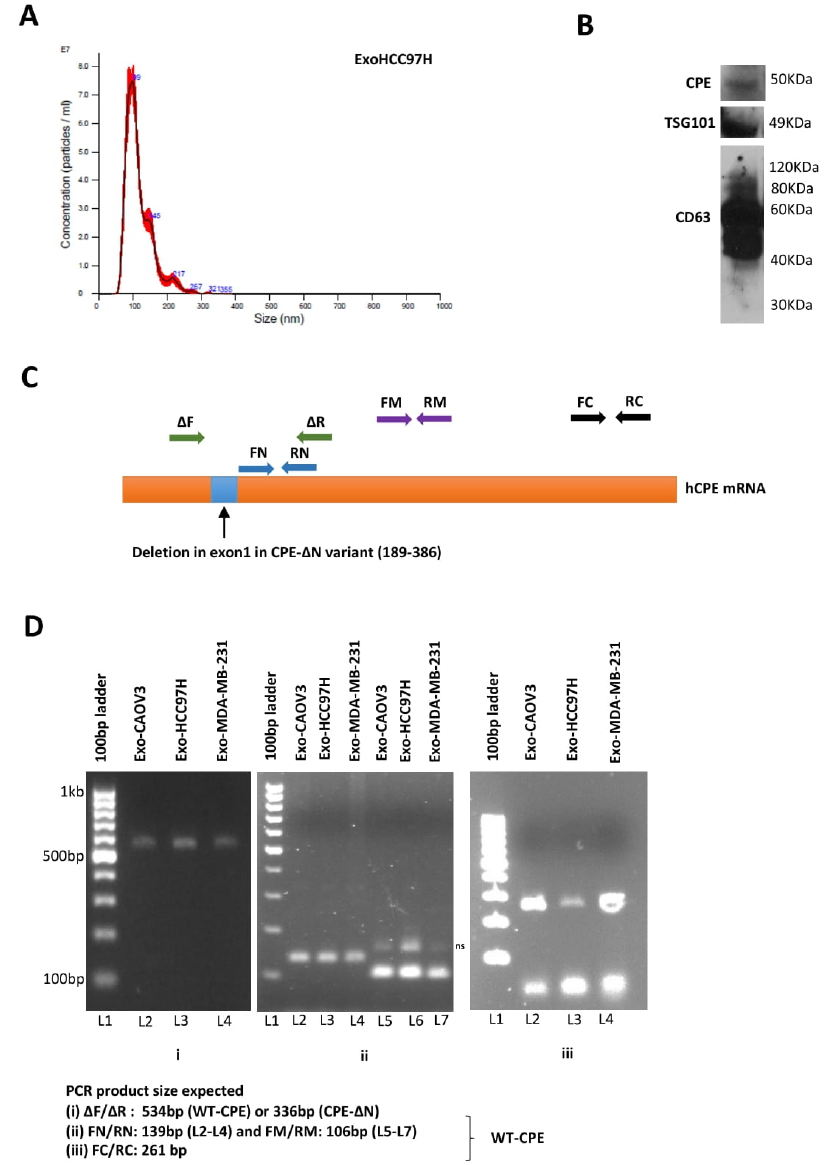
Figure 1. Detection of CPE in cancer cell exosomes. ( A ) Characterization of metastatic liver cancer cell derived exosomes: Representative graph (left panel) showing the concentration plotted against particle size of exosomes released from HCC97H cells, determined using NanoSight analysis. ( B ) Western blot showing WT-CPE and exosomal markers TSG101 and CD63 in exosomes released from HCC97H cells. ( C ) Schematic showing human CPE mRNA with the position of RT-PCR primers used to detect CPE gene fragments. The region of deletion seen in exon 1 of CPE- Δ N variant, another isoform of CPE detected in cancer cells is marked as a blue box and the ∆ F/ ∆ R primer set used to distinguish WT-CPE and CPE- Δ N sequences are denoted by green arrows. ( D ) Exosomes isolated from CAOV3, HCC97H and MDA-MB-231 cells were analyzed using RT-PCR to determine the presence of CPE transcripts. Images of agarose gels showing the amplicons generated using the primers specific for 5 ′ -end (Dii), middle (Dii)or 3 ′ -end parts of CPE mRNA (Diii), besides the region flanking the exon 1 deletion in CPE- Δ N sequence (Di). The expected PCR product sizes are given below the gel images. Major band sizes represented by the 100 bp DNA ladder are shown in D(i). ‘ns’ refers to non-specific band in D(ii).